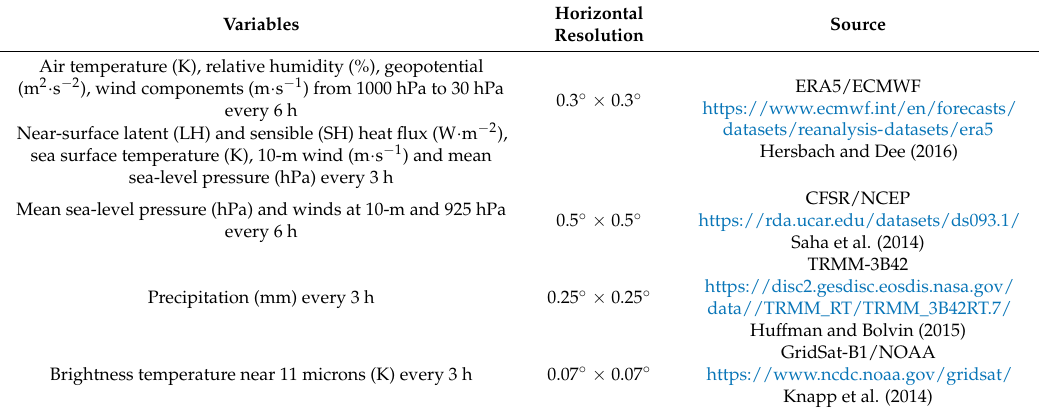
Table 1. Description of the dataset used in the